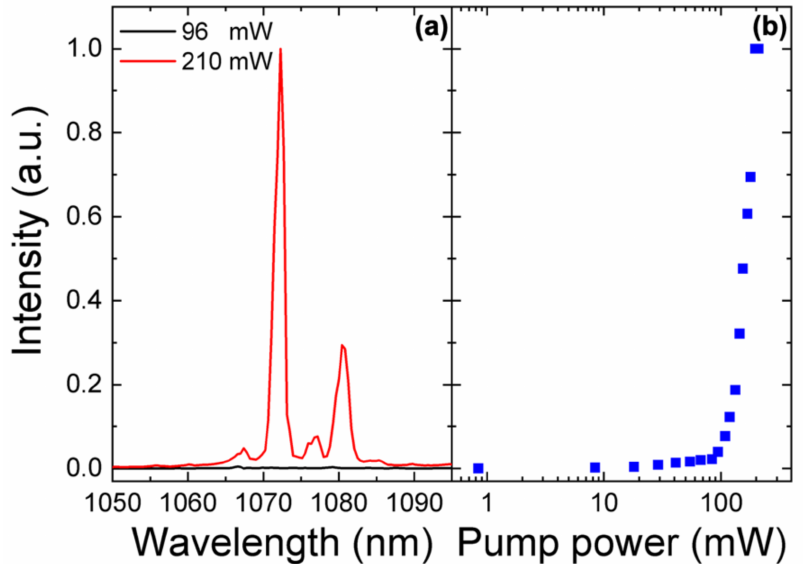
Figure 6. ( a ) Emission spectra of a YAS:Nd 3+ microsphere at pump powers below the laser threshold (black line) and above the threshold (red line); ( b ) intensity of the 1072 laser emission at different pump